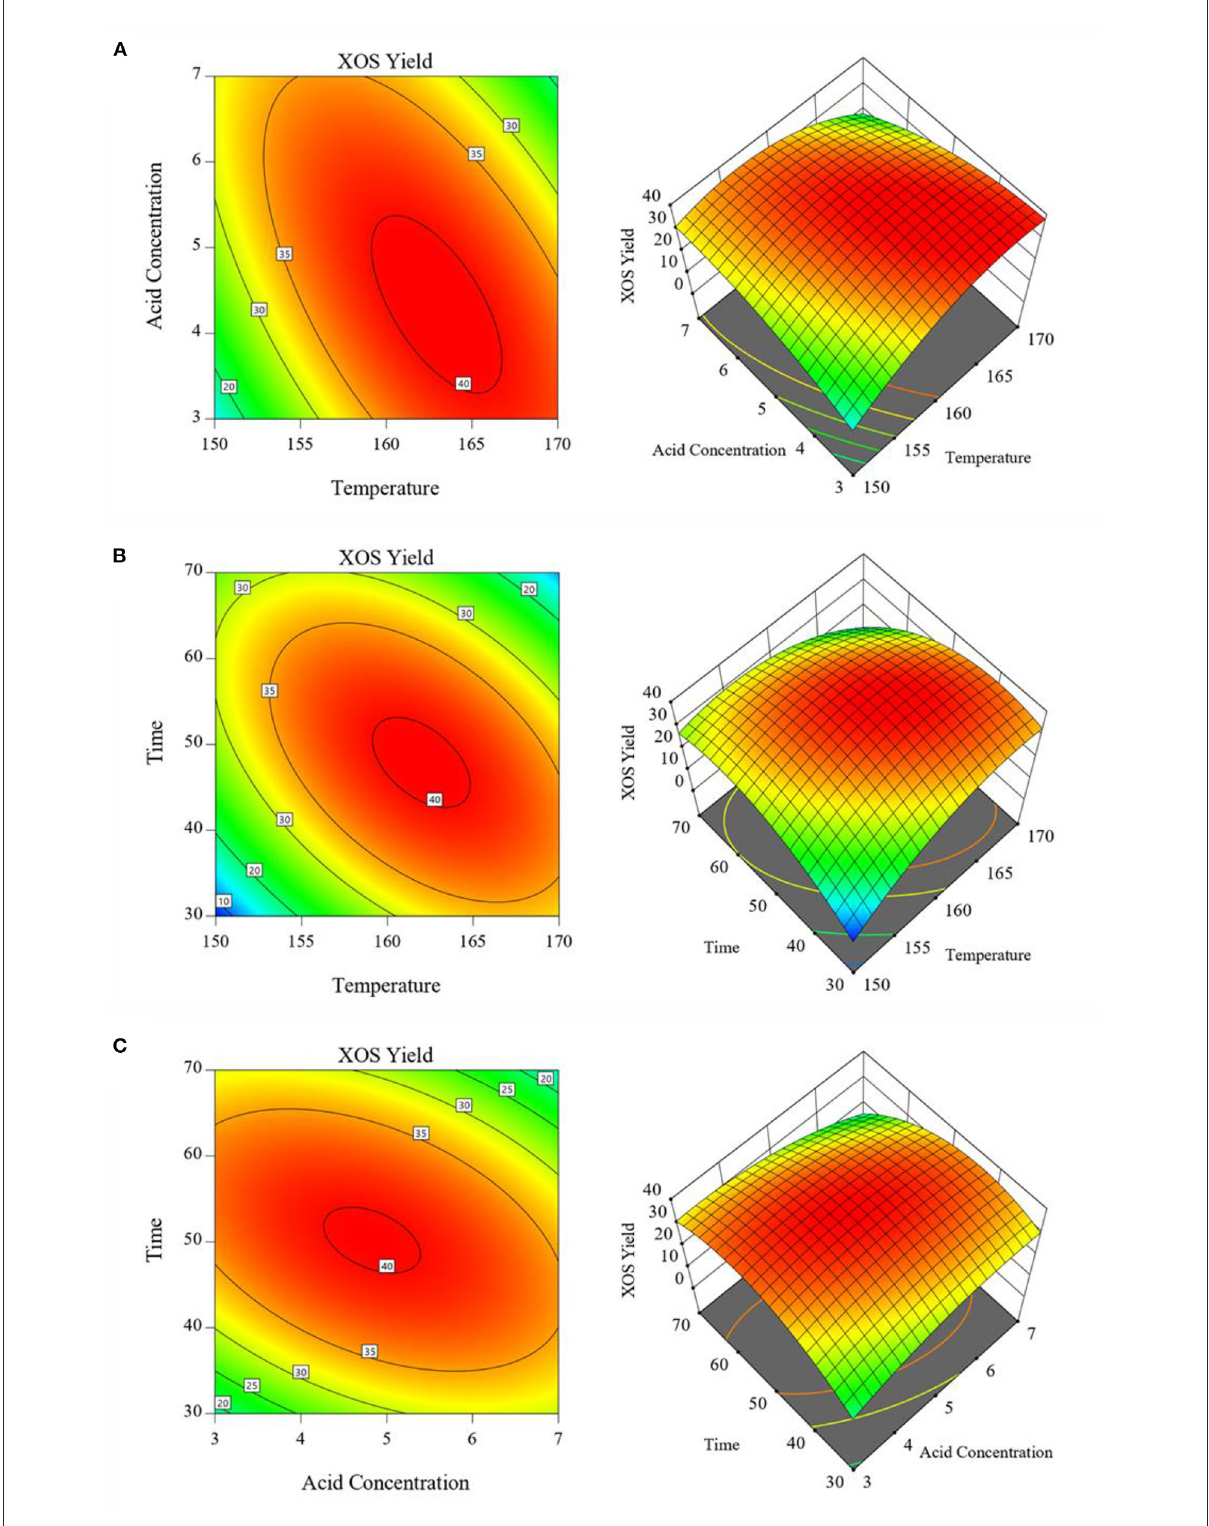
FIGURE3 Response surface showing the effects of independent variables on XOS yields: (A) Reaction temperature and GluA concentration; (B) Reaction temperature and hydrolysis period; (C) GluA concentration and hydrolysis period. XOS, xylooligosaccharides.